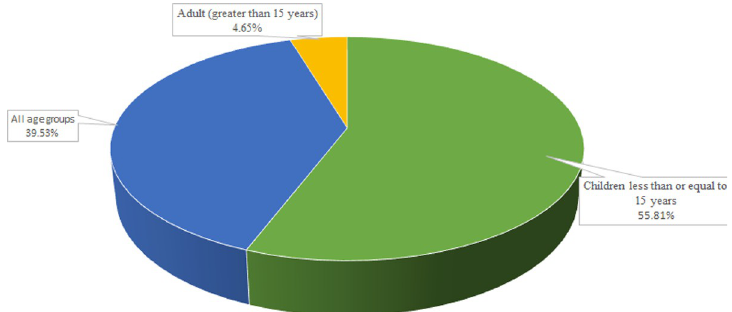
Fig 3. Age categories and percentage of published articles.